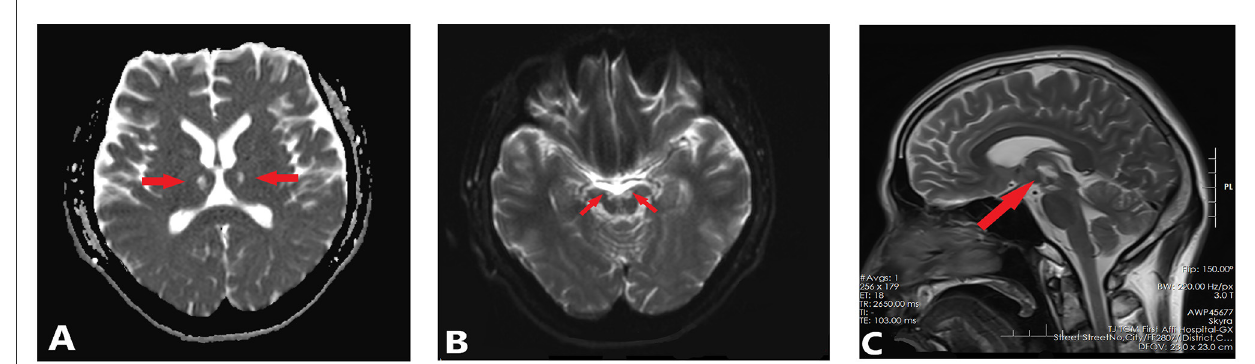
FIGURE2 MRI revealed abnormal signals in the midbrain and thalamus. (A) The axial scanning of MRI revealed bilateral thalamic infarcts (DWI, diffusion-weighted imaging). (B) The axial scanning of MRI revealed Mesencephalic infarction (DWI, diffusion-weighted imaging). (C) The sagittal scanning of MRI revealed Mesencephalic infarction(T2-weighted MR